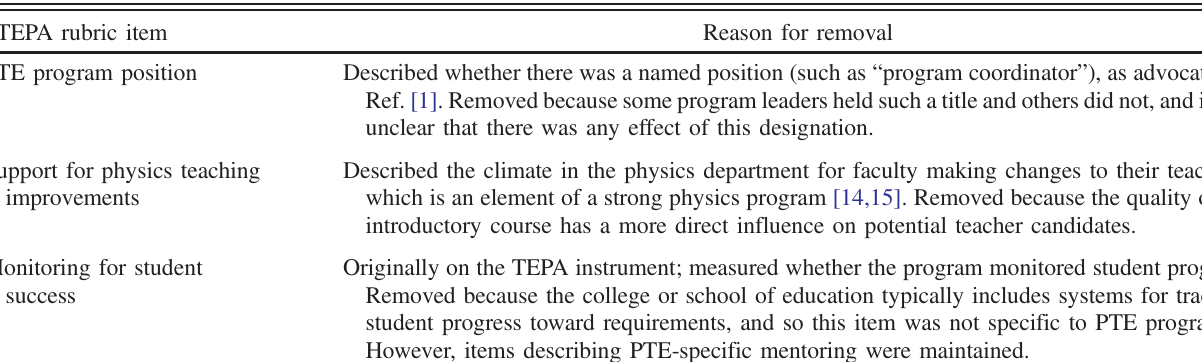
TABLE II. A sample of items removed from the PTEPA rubric. PTEPA rubric